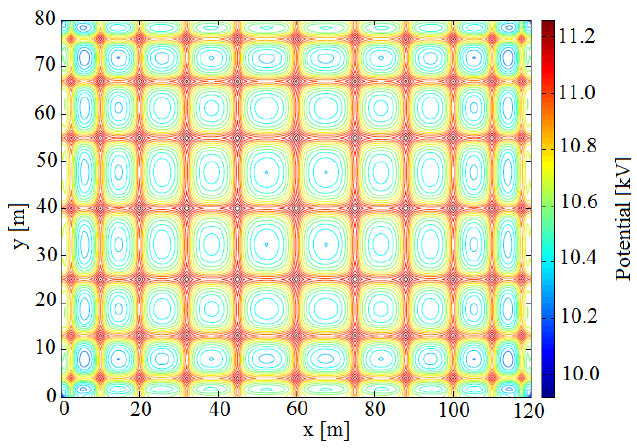
Fig. 9 Equipotential distributed on the soil surface.